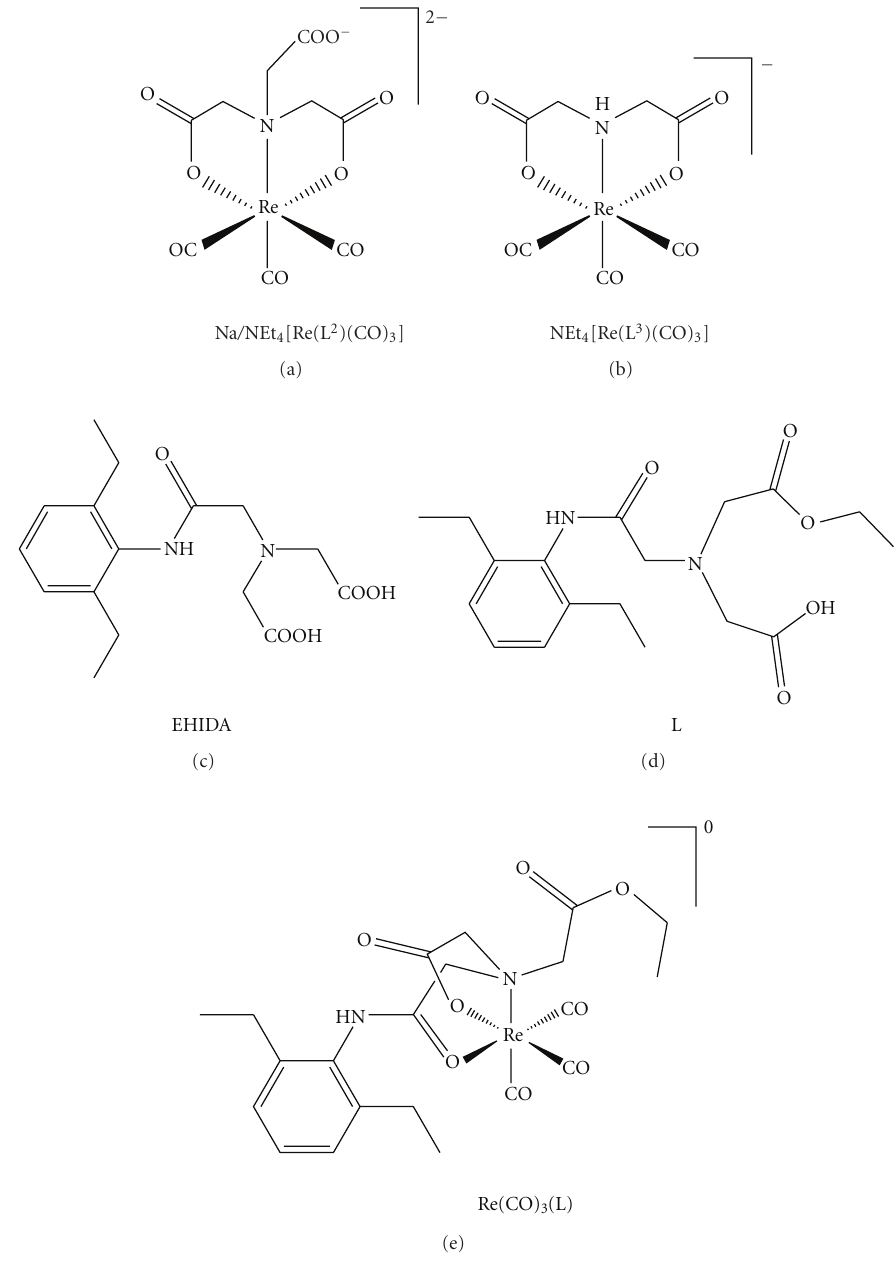
Figure 5: Structures of Na/NEt 4 [Re(L 2 )(CO) 3 ], NEt 4 [Re(L 3 )(CO) 3 ] [11] EHIDA, L, and Re(CO) 3 (L).